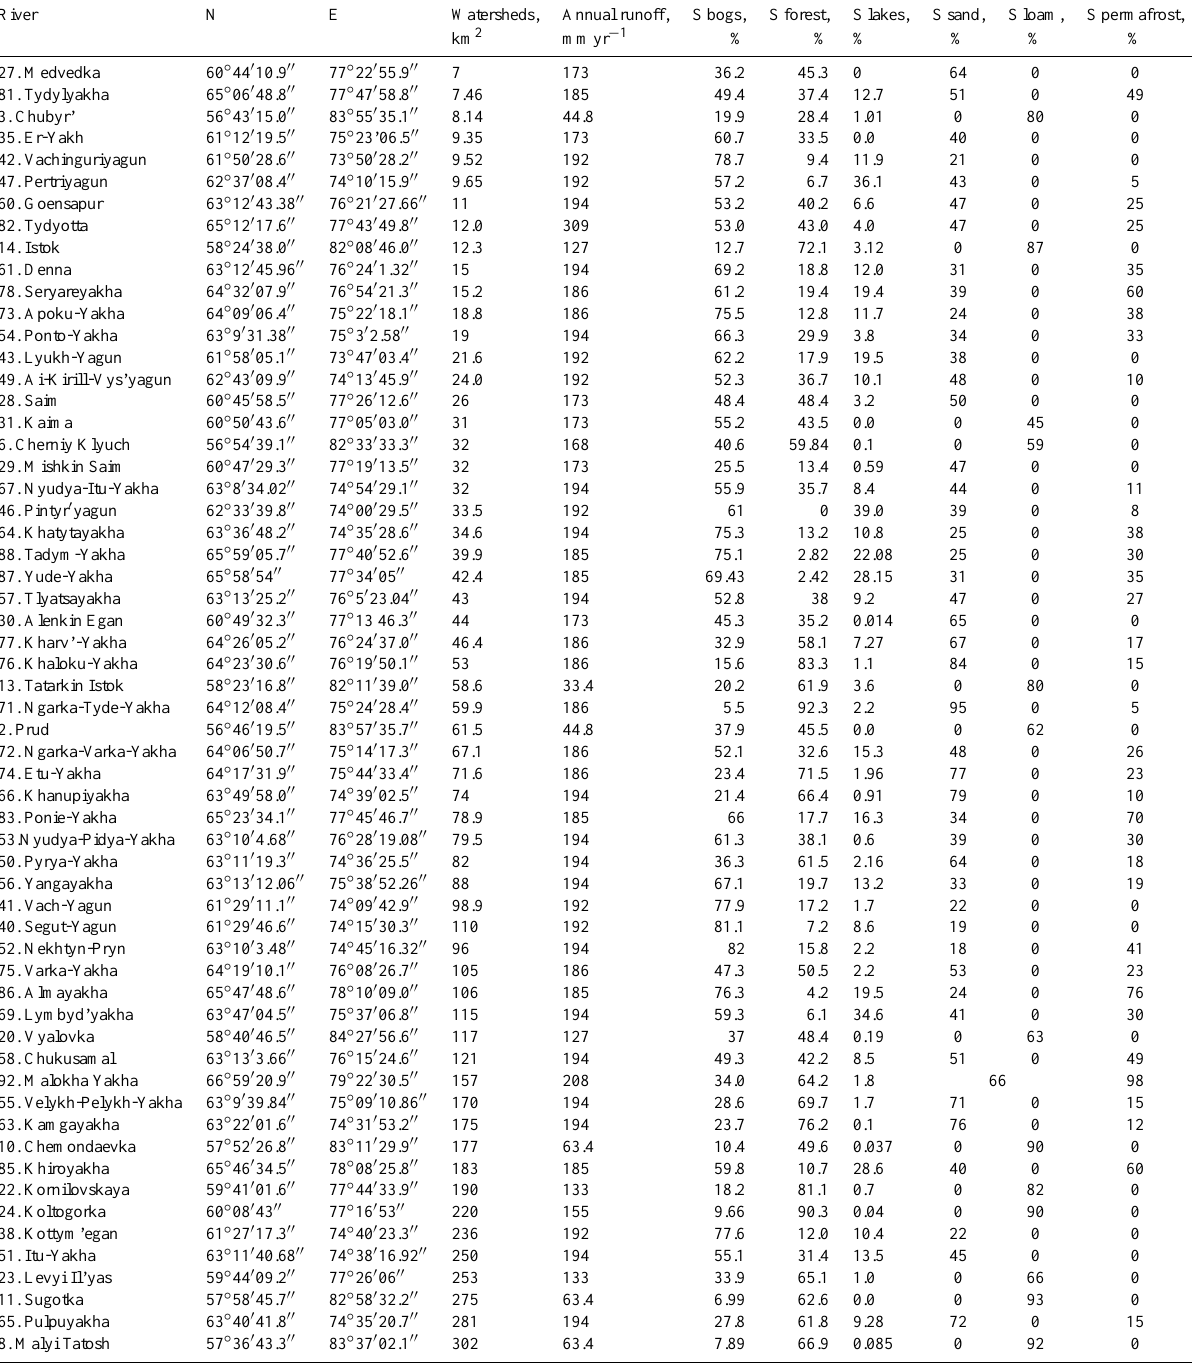
Table 1. List of sampled rivers, their watershed area, annual runoff, landscape parameters of the watershed (% of bogs, lakes and forest coverage), lithology (% of sand, loam and clay; the rest is peat) and permafrost coverage. The numbers in the first column represent the rivers in the map (Fig. 1). Rivers 27 (Medvedka), 30 (Alenkin Egan), 35 (Er-Yakh), 66 (Khanupiyakha), 33 (Mokhovaya), 74 (Etu-Yakha), 77 (Kharv’-Yakha), 31 (Kaima) and 65 (Pulpuyakha) are influenced by industrial oil activities (18, 20, 11, 6, 3, 2, 2, 1 and 1% of watershed, respectively). Rivers 29 (Mishkin Saim), 3 (Chubyr’), 4 (Shegarka), 10 (Chemondaevka), 11 (Sugotka), 5 (Brovka), 8 (Malyi Tatosh), 2 (Prud), 20 (Vyalovka) and 16 (Chigas) are affected by agricultural activity (61, 51, 40, 38, 30, 30, 25, 17, 14 and 13% of watershed, respec- tively). Rivers 14 (Istok) and 13 (Tatarkin istok) are within the Ob River flooding zone with meadow vegetation (14 and 12% of watershed, respectively). The lithology of watersheds 92 (Malokha Yakha), 93 (Nuny-Yakha) and 95 (Khadutte) is represented by the interlayer mixture of sand, loam and clays (66, 76 and 84%, respectively). ND stands for non-determined.